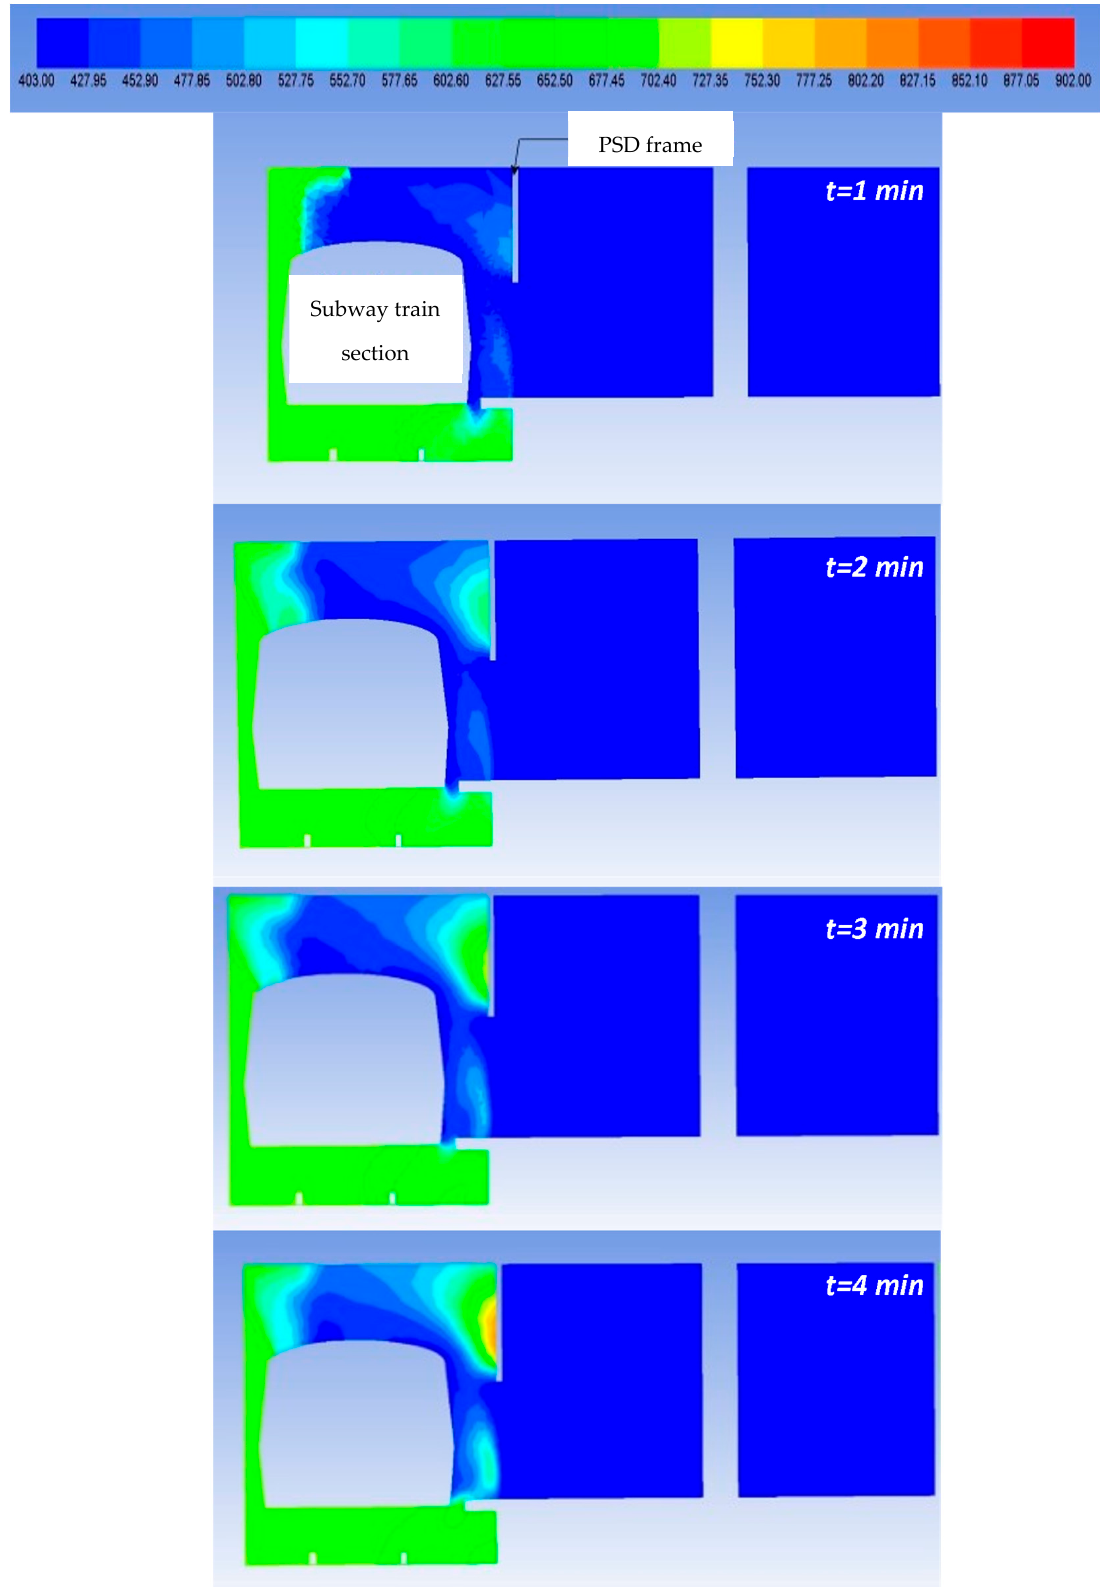
Figure 22. CO 2 contours (ppm)—cross section through the door of the PSD system near the fire outbreak (minutes 1–4).